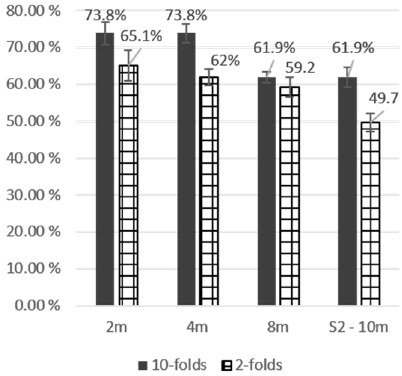
Figure 4. Comparison of results (OA) of 2-fold and 10-folds methods for the “families” nomenclature with the MNF DR.